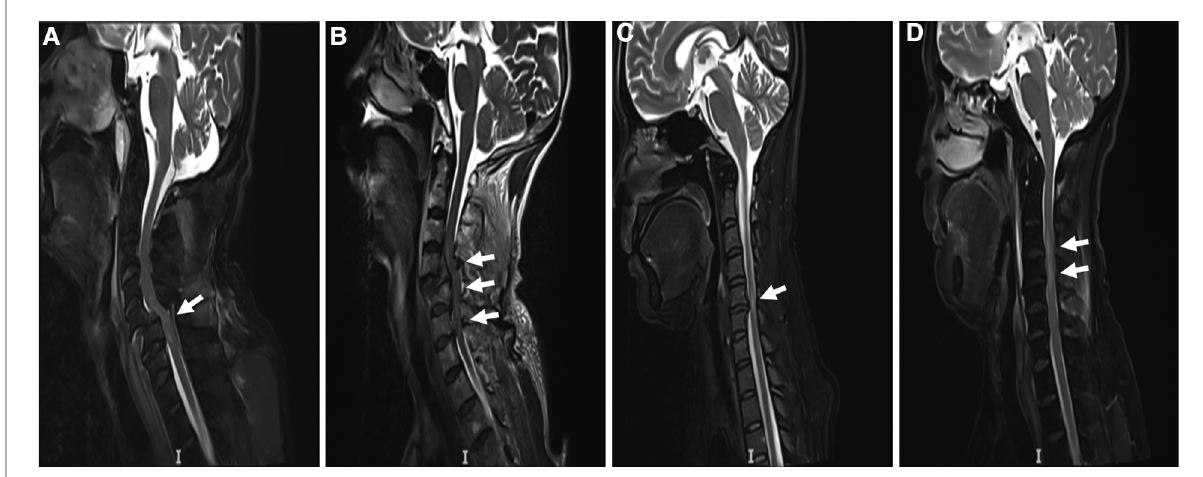
FIGURE 4 Two typical MRI scans of TCSCI patients. MRI scans of TCSCI patients with fracture/dislocation and disc herniation/bulging. ( A ) The C5 vertebral body slipped forward to the III° position; the spinal canal was narrowed and the cervical spinal cord was severely compressed. ( B ) The C4 vertebral body slipped forward to the II° position and a TCSCI is evident at the C4 -6 level. ( C ) The C5/6 intervertebral disc herniated backward and a TCSCI is apparent at the C5/6 level, especially C5. ( D ) The C3/4, C4/5, C5/6, and C6/7 intervertebral discs herniated posteriorly and a TCSCI is apparent at the C3/C4 level.